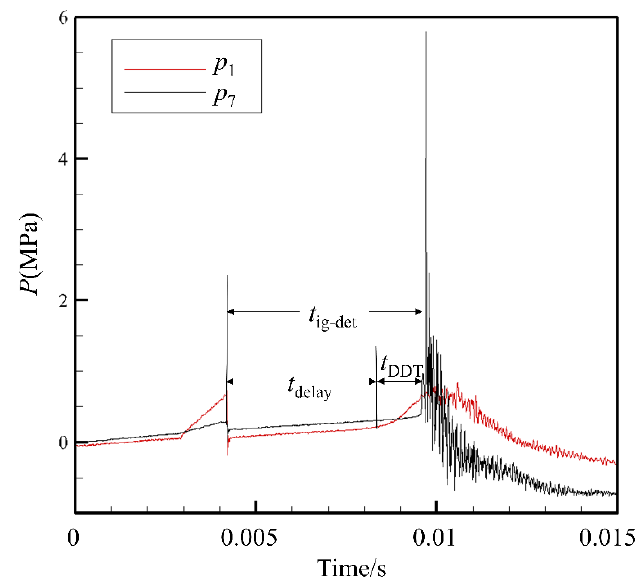
Figure 7. Schematic of the definition of detonation initiation time, jet ignition time and DDT time.